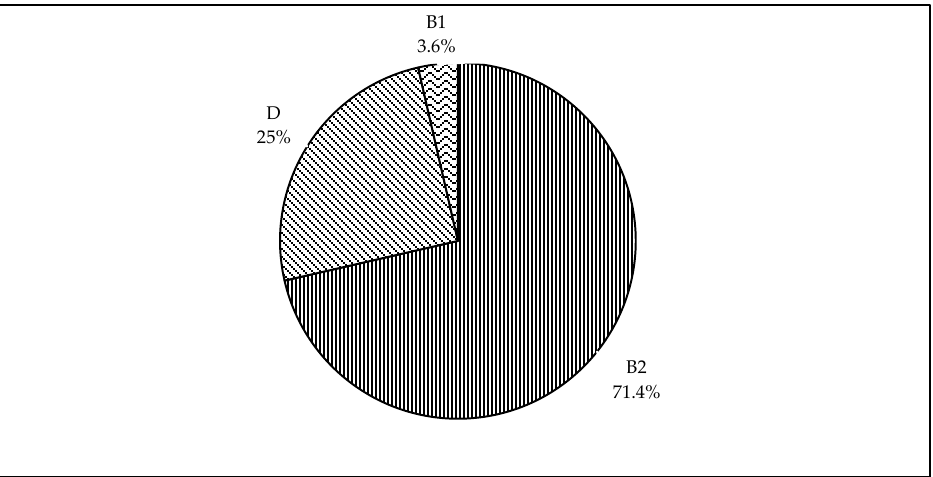
Figure 2. Pie chart showing phylogenetic classification of broiler breeder APEC isolates. The phylogenetic groups identified among the 28 isolates were B2, D, and B1; and each segment represent the percentage prevalence.